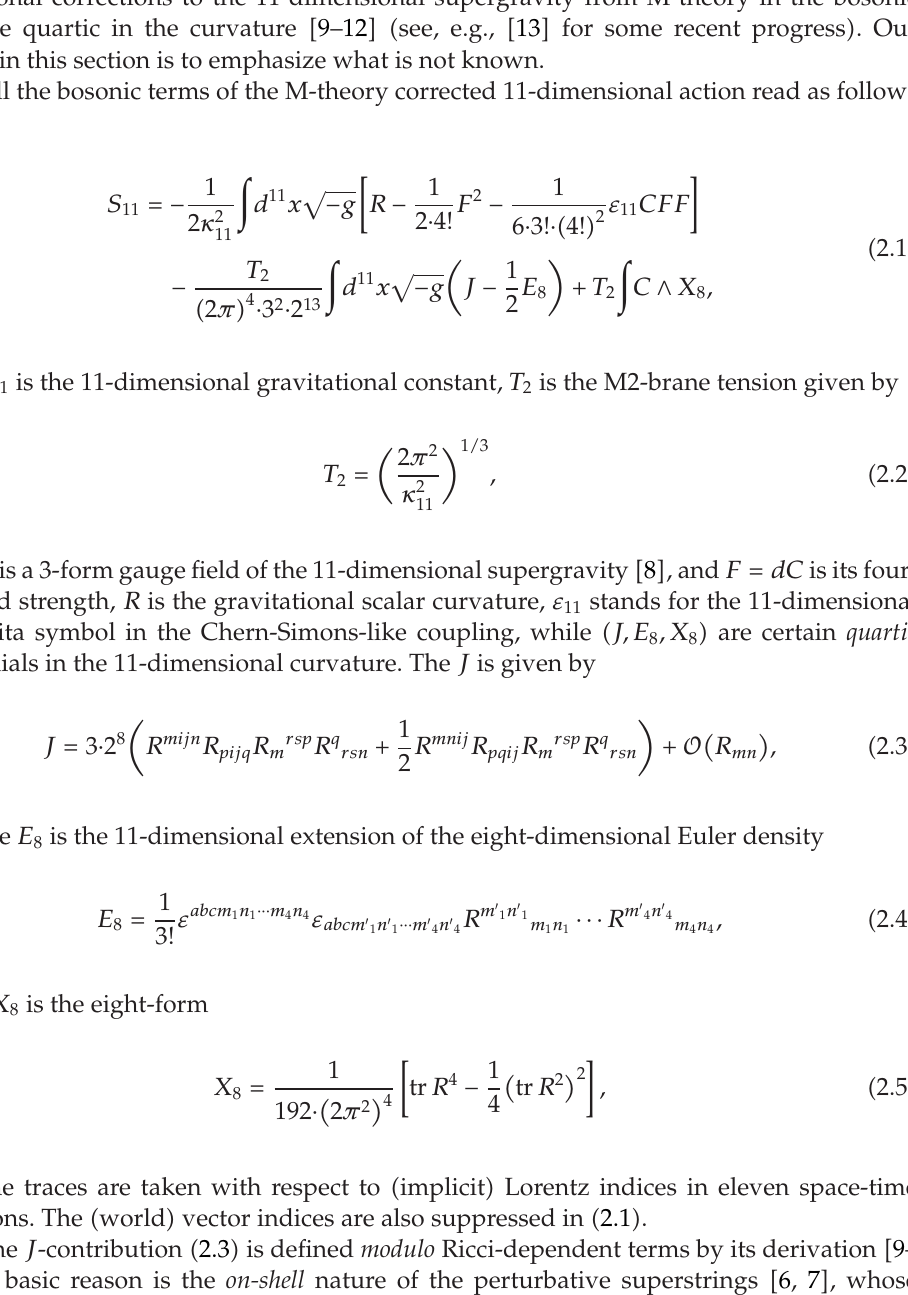
e ff ective action is given by the 11-dimensional supergravity (cid:5) 8 (cid:6) , and (cid:2) ii (cid:3) the leading quantum gravitational corrections to the 11-dimensional supergravity from M-theory in the bosonic sector are quartic in the curvature (cid:5) 9–12 (cid:6) (cid:2) see, e.g., (cid:5) 13 (cid:6) for some recent progress (cid:3) . Our purpose in this section is to emphasize what is not